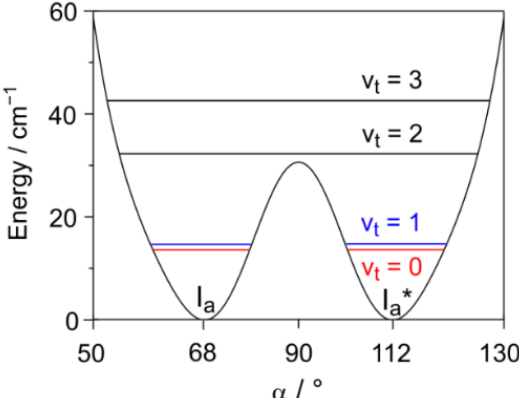
Figure 6. An enlarged portion from 50° to 130° of the potential energy curve given in Figure 3. The doubly degenerate lowest tunneling energy levels v t = 0, 1, 2, 3 are indicated by horizontal lines. The difference between the first two levels, v t = 0 and 1, is only 1.022 cm − 1 , corre- sponding to 30.64 GHz, which is the value of Δ E 01 . Calculating the Boltzmann distribution yields an N 1 /N 0 ratio of 0.23 to 0.48 for a temperature of 1 to 2 K, i.e., the population of the first excited state v t = 1 is expected to be 23 to 48% with respect to the ground state v t = 0.